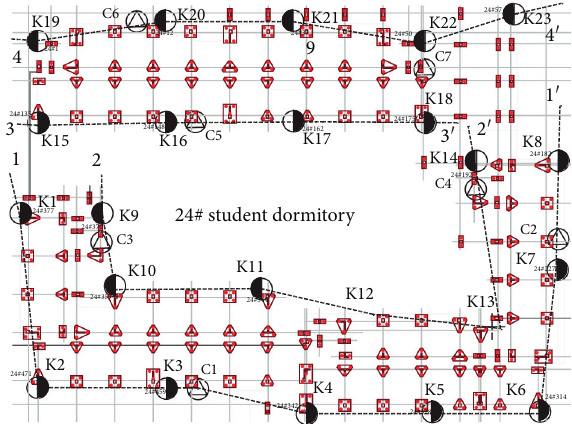
Figure 5: The investigation site with pile location layout of 24# student